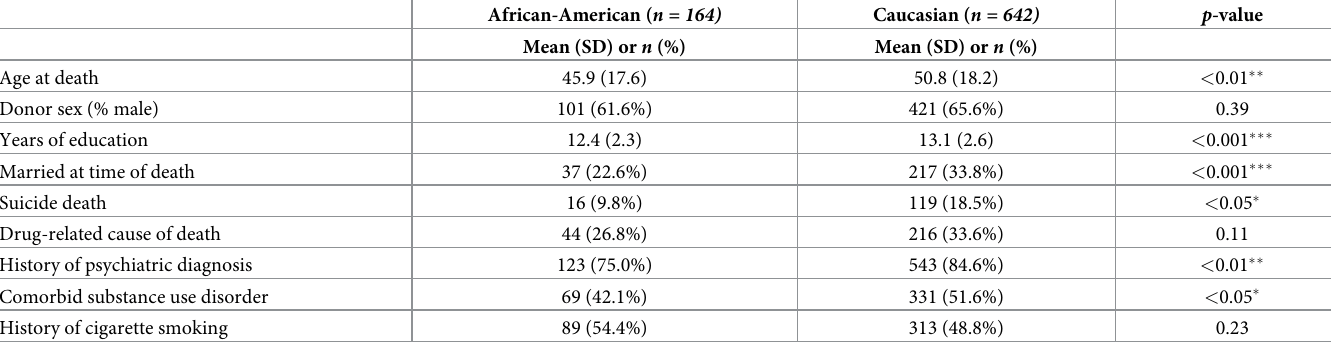
Table 2. Postmortem human brain donor